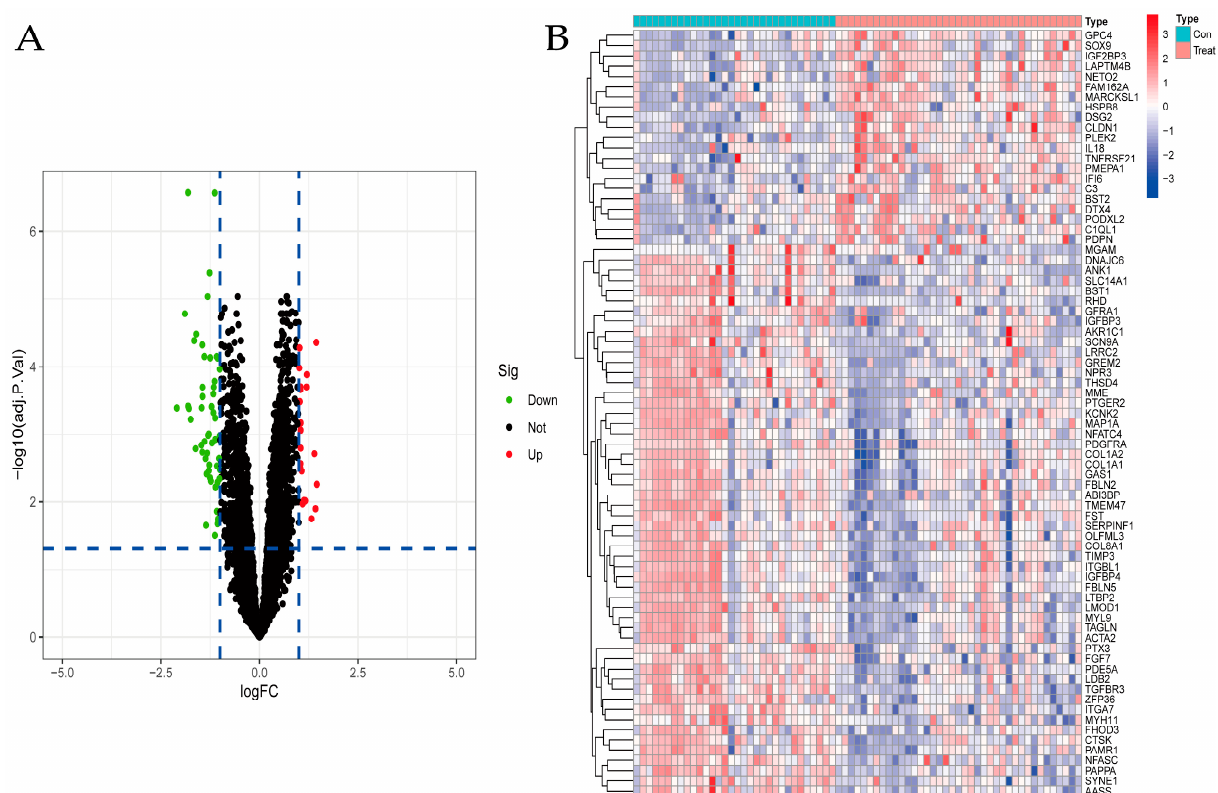
Figure 2. Seventy − five expression − related genes were extracted after differentially expressed gene analysis, 21 genes were upregulated, and 54 genes were downregulated in osteosarcoma tissues (Treat) compared with normal tissues (Con). ( A ) Volcano plot of DFGs between the normal and OS groups. ( B ) Heatmap of DEGs between the normal and OS